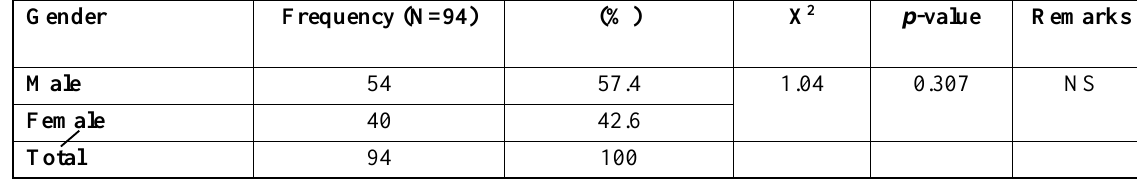
Table 4. Prevalence of astrovirus based on gender among the infected children.